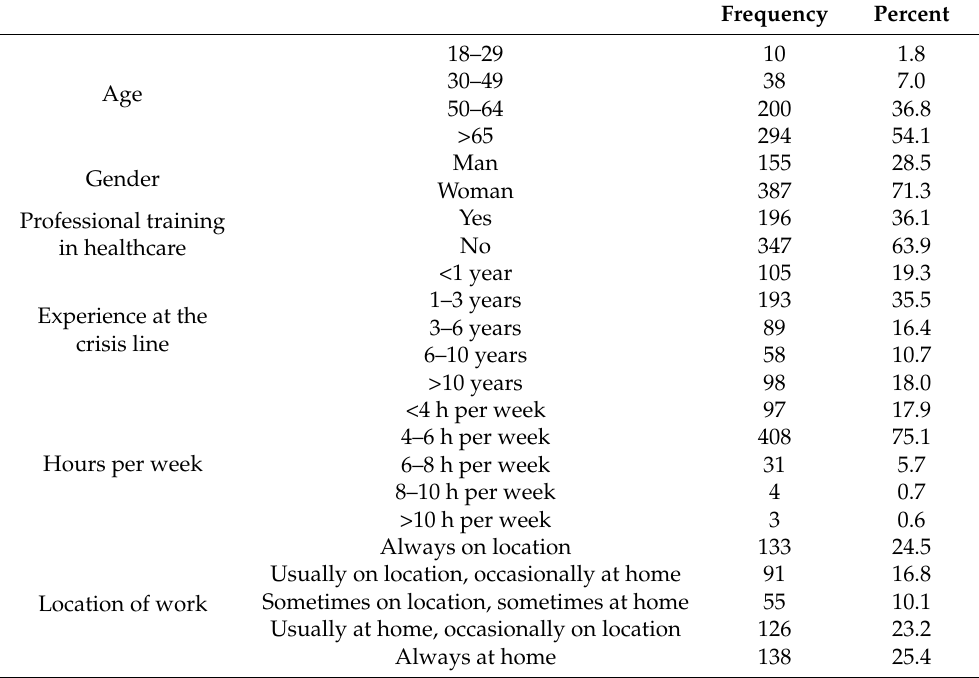
Table 1. Demographics and work-related information (N = 543).